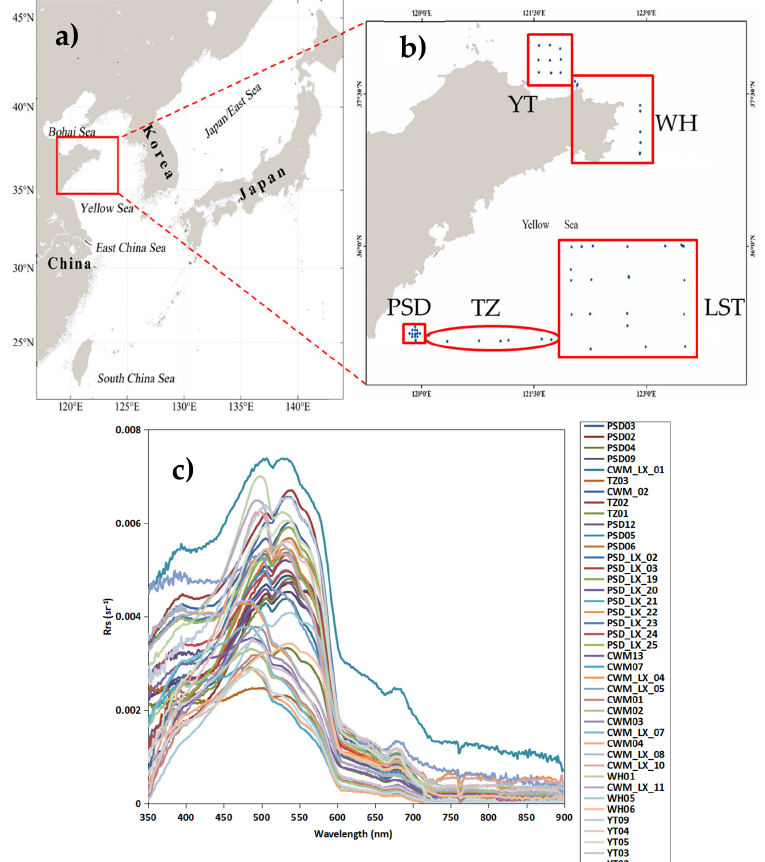
Figure 2. ( a ) Map of the region of interest, including the Bohai Sea, the Yellow Sea (YS), the East China Sea, the Japan/East Sea, and part of the South China Sea. The red box identifies the region over the YS used to analyze the temporal variability of atmospheric and water optical parameters measured by GOCI. ( b ) Locations of in situ data acquisition in the Yellow Sea in August 2017 are marked in solid blue circles. Five subregions that represent the different field data are marked where PSD represents PingShan Island, CWM denotes the Cold Water Mass, and TZ stands for the transitional zone between them. WH refers to the region over Weihai, and YT represents Yantai. For the spectra of remote sensing reflectance (Rrs) for each subregion, please refer to the Appendix A. ( c ) Spectra of Rrs at all 18 daytime